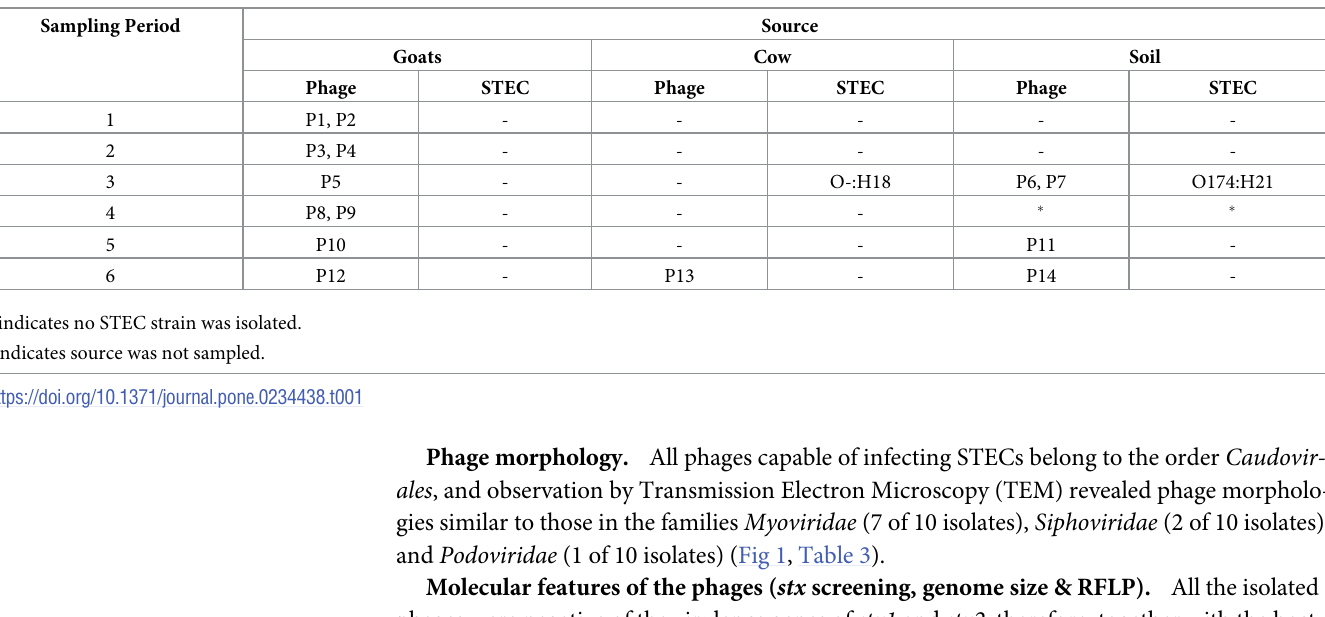
Table 1. Isolation of STEC-specific phage and STEC from different environmental sources and sampling periods. Sampling Period